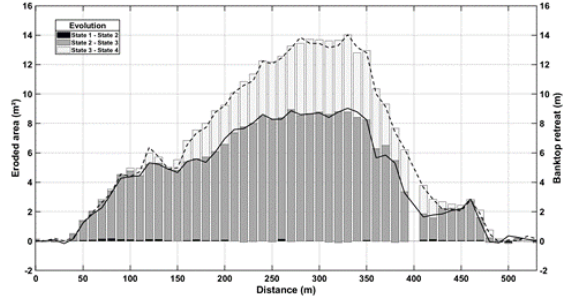
Figure 8: Cumulative normalized eroded areas (diagrams) and corresponding banktop retreats